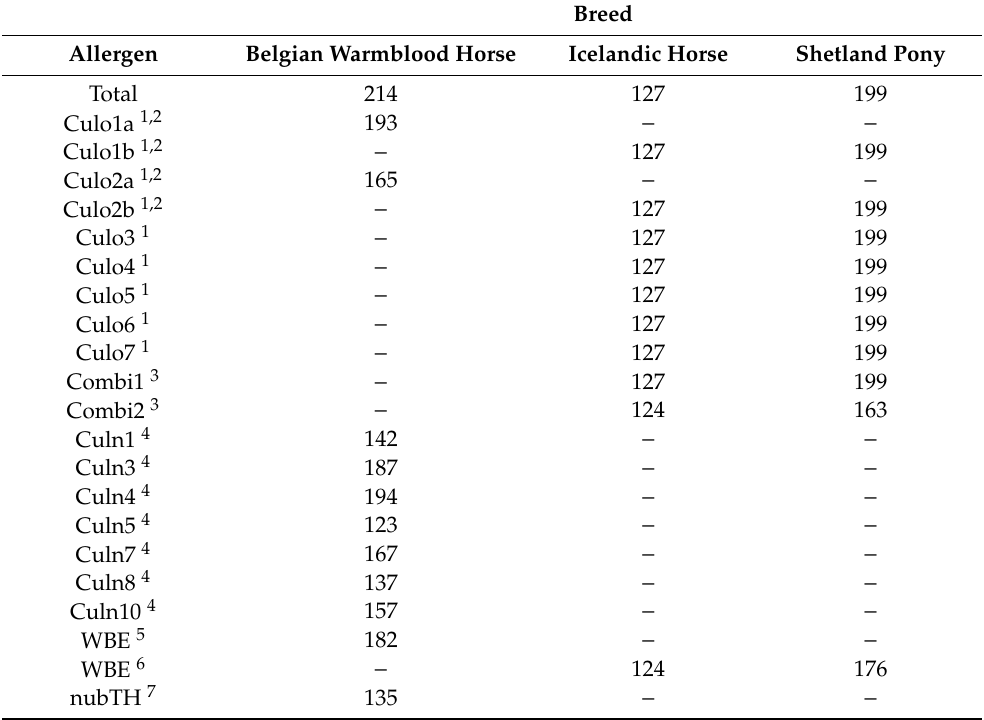
Table 1. Number of horses tested for (recombinant) allergens of Culicoides obsoletus and Culicoides nubeculosus in the Belgian Warmblood horse, Icelandic horse, and Shetland pony breeds. Breed Allergen Belgian Warmblood Horse Icelandic Horse Shetland Pony Total